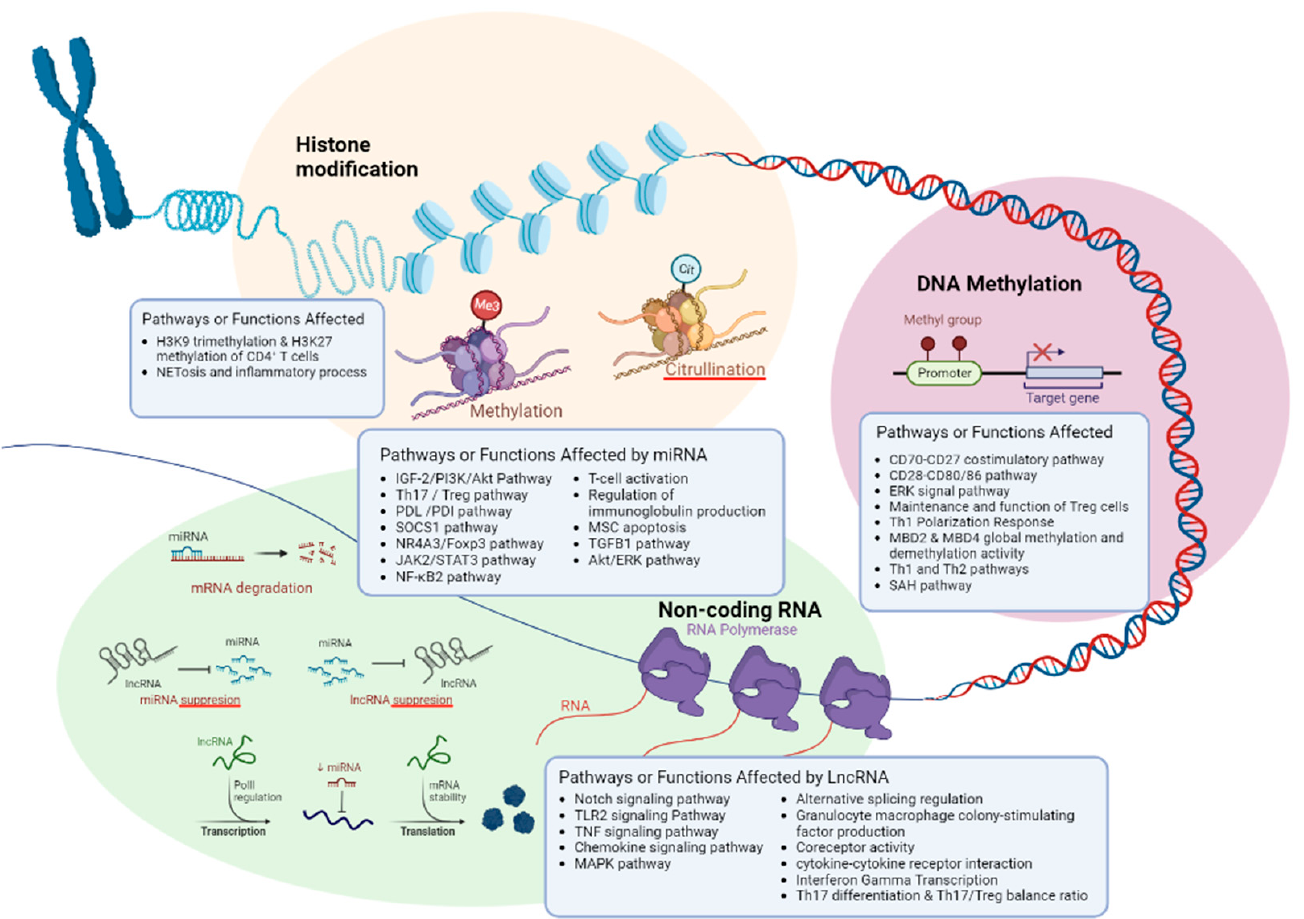
Figure 2. Epigenetic mechanisms in ITP. Created with BioRender.com (accessed on 1 February 2023).